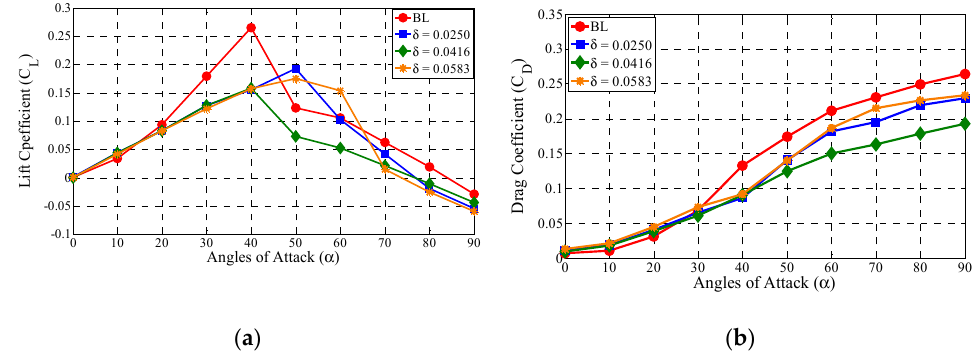
Figure 10. ( a ) The aerodynamic behavior of lift and ( b ) drag coefficient as functions of angles of attack for various circular slot ratios ( δ ).